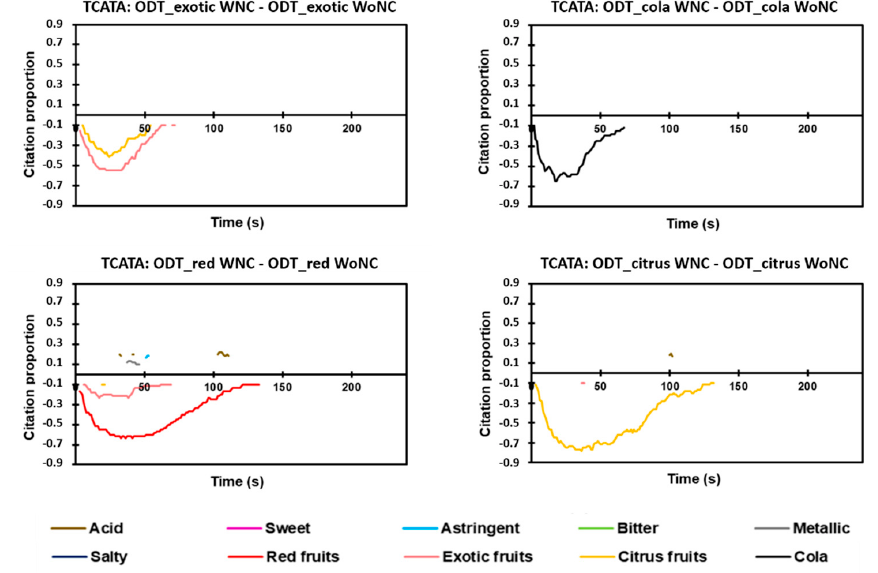
Figure 7. Difference curves for TCATA (Temporal Check-All-That-Apply) between a given pair of the same product (nose-clip evaluation and without nose-clip evaluation) based on 95% Fisher’s exact test. WNC, with nose-clip. WoNC, without nose-clip.